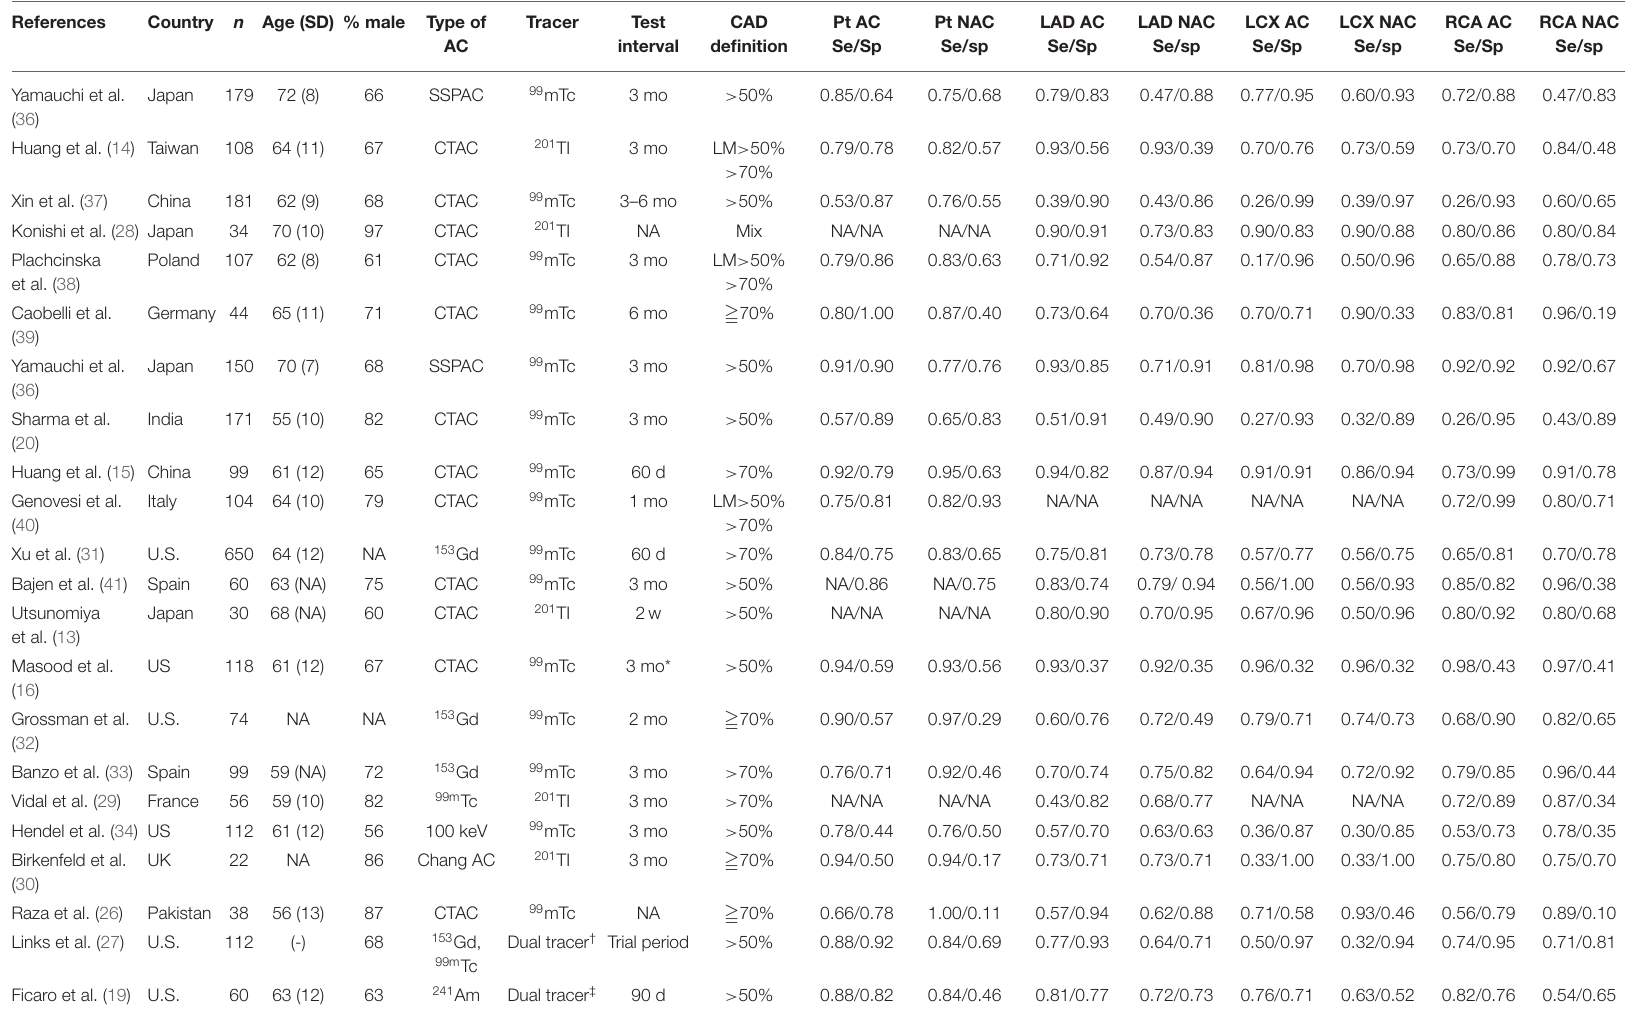
TABLE 1 | Characteristics of the selected